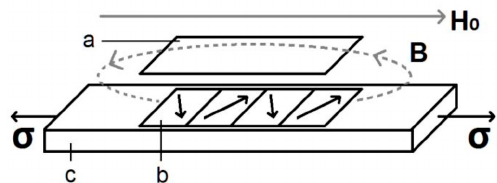
Figure 2. Schematic representation of a wireless strain sensor based on the Δ E effect: (a) resonator, (b) transducer, and (c) test object. Adapted from [22].